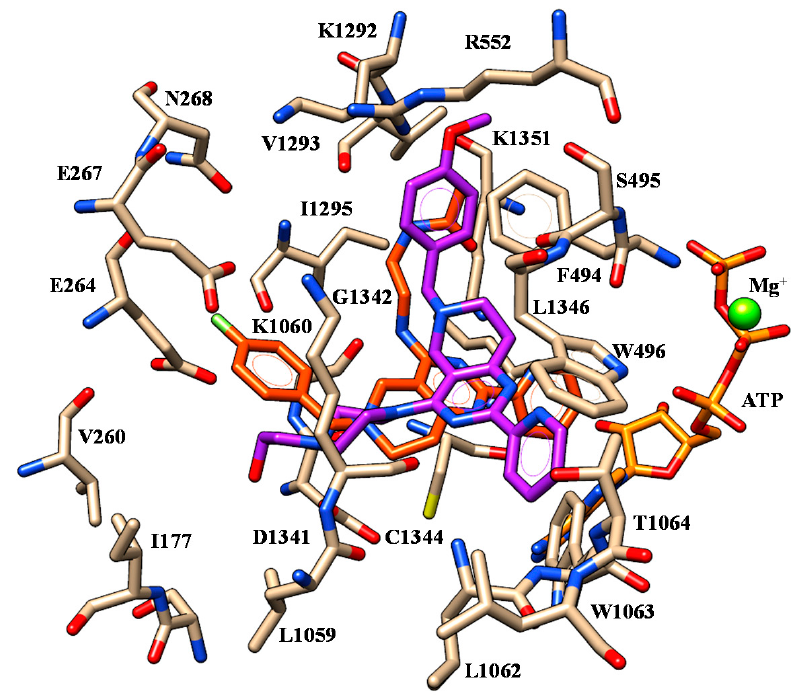
Figure 13. Selected docking mode of 43 (C atom; violet) and 50 (C atom; orange) within the modelled F508del-CFTR. The most important residues are labelled.